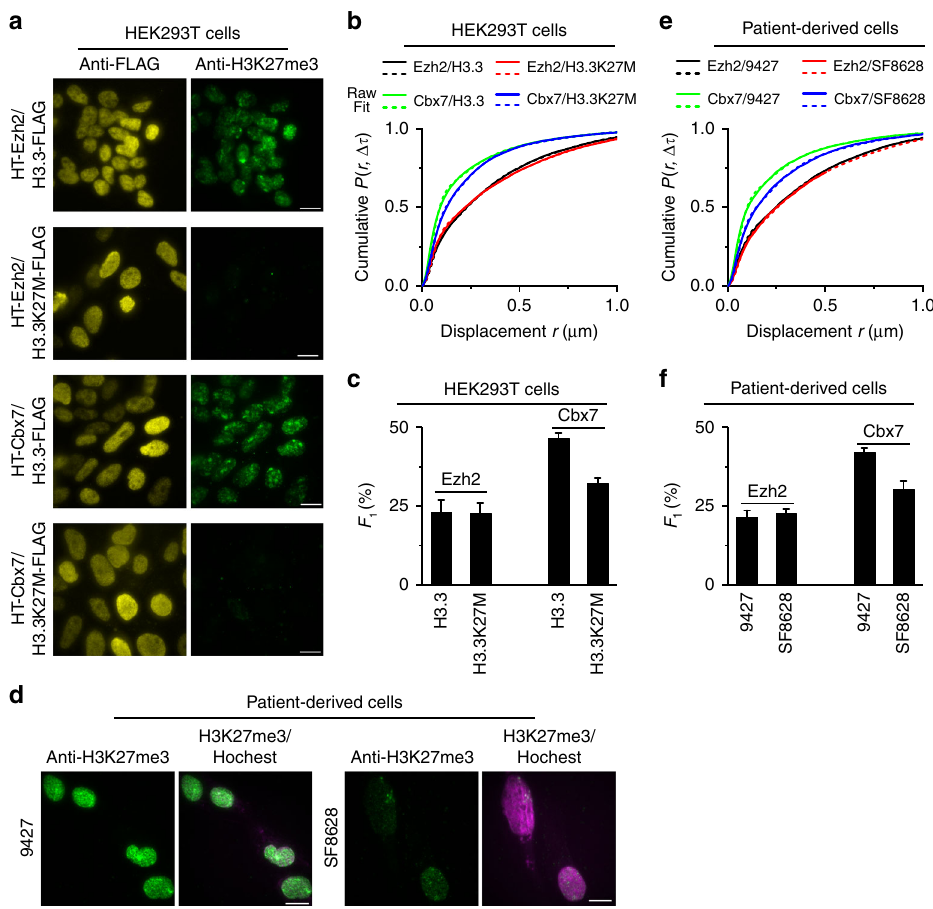
Fig. 4 The DIPG H3.3K27M mutation reduces the Cbx7 level bound to chromatin, but has no effect on Ezh2. a Co-immunostaining of FLAG (yellow) and H3K27me3 (green) in HEK293T cells expressing HaloTag-Ezh2/H3.3-FLAG , HaloTag-Ezh2/H3.3K27M-FLAG , HaloTag-Cbx7/H3.3-FLAG , or HaloTag-Cbx7/ H3.3K27M-FLAG . Quanti fi cation analysis showed that the H3K27me3 level in HEK293T cells expressing H3.3K27M-FLAG is ∼ 7.0-fold lower compared to that expressing H3.3-FLAG (Supplementary Fig. 2). Scale bar, 5.0 µ m. b Cumulative distribution of displacements for HaloTag-Ezh2 in HEK293T cells expressing H3.3-FLAG ( N = 54 cells, n = 9034 displacements) or H3.3K27M-FLAG ( N = 127 cells, n = 22,273 displacements), and for HaloTag-Cbx7 in HEK293T cells expressing H3.3-FLAG ( N = 78 cells, n = 14,101 displacements) or H3.3K27M-FLAG ( N = 89 cells, n = 15,755 displacements). The distributions were decomposed into three populations. Fitted parameters are shown in Supplementary Table 5. c Fraction of the chromatin-bound population ( F 1 ) for HaloTag-Ezh2 or HaloTag-Cbx7 in HEK293T cells expressing H3.3-FLAG or H3.3K27M-FLAG . The data were obtained from Fig. 4b. Results are means ± SD. d Immunostaining of H3K27me3 in patient-derived SF8628 and control brain tumor 9427 cells by using antibody directed against H3K27me3 (green). DNA was stained with hoechst (red). Overlay images are shown. The H3K27me3 level in 9427 cells was ∼ 2.0-fold higher than that in SF8628 cells (Supplementary Fig. 2). Scale bar, 5.0 µ m. e Cumulative distribution of displacements for HaloTag-Ezh2 in 9427 ( N = 73 cells, n = 6806 displacements) and SF8628 ( N = 43 cells, n = 6900 displacements) cells, and for HaloTag-Cbx7 in 9427 ( N = 37 cells, n = 5280 displacements) and SF8628 ( N = 32 cells, n = 8181 displacements) cells. The histograms were fi tted with three components. Fitted data are shown in Supplementary Table 5. f Fraction of the chromatin-bound population ( F 1 ) for HaloTag-Ezh2 in 9427 and SF8628 cells and for HaloTag-Cbx7 in 9427 and SF8628 cells. The data were obtained from e . Results are means± SD from three biological